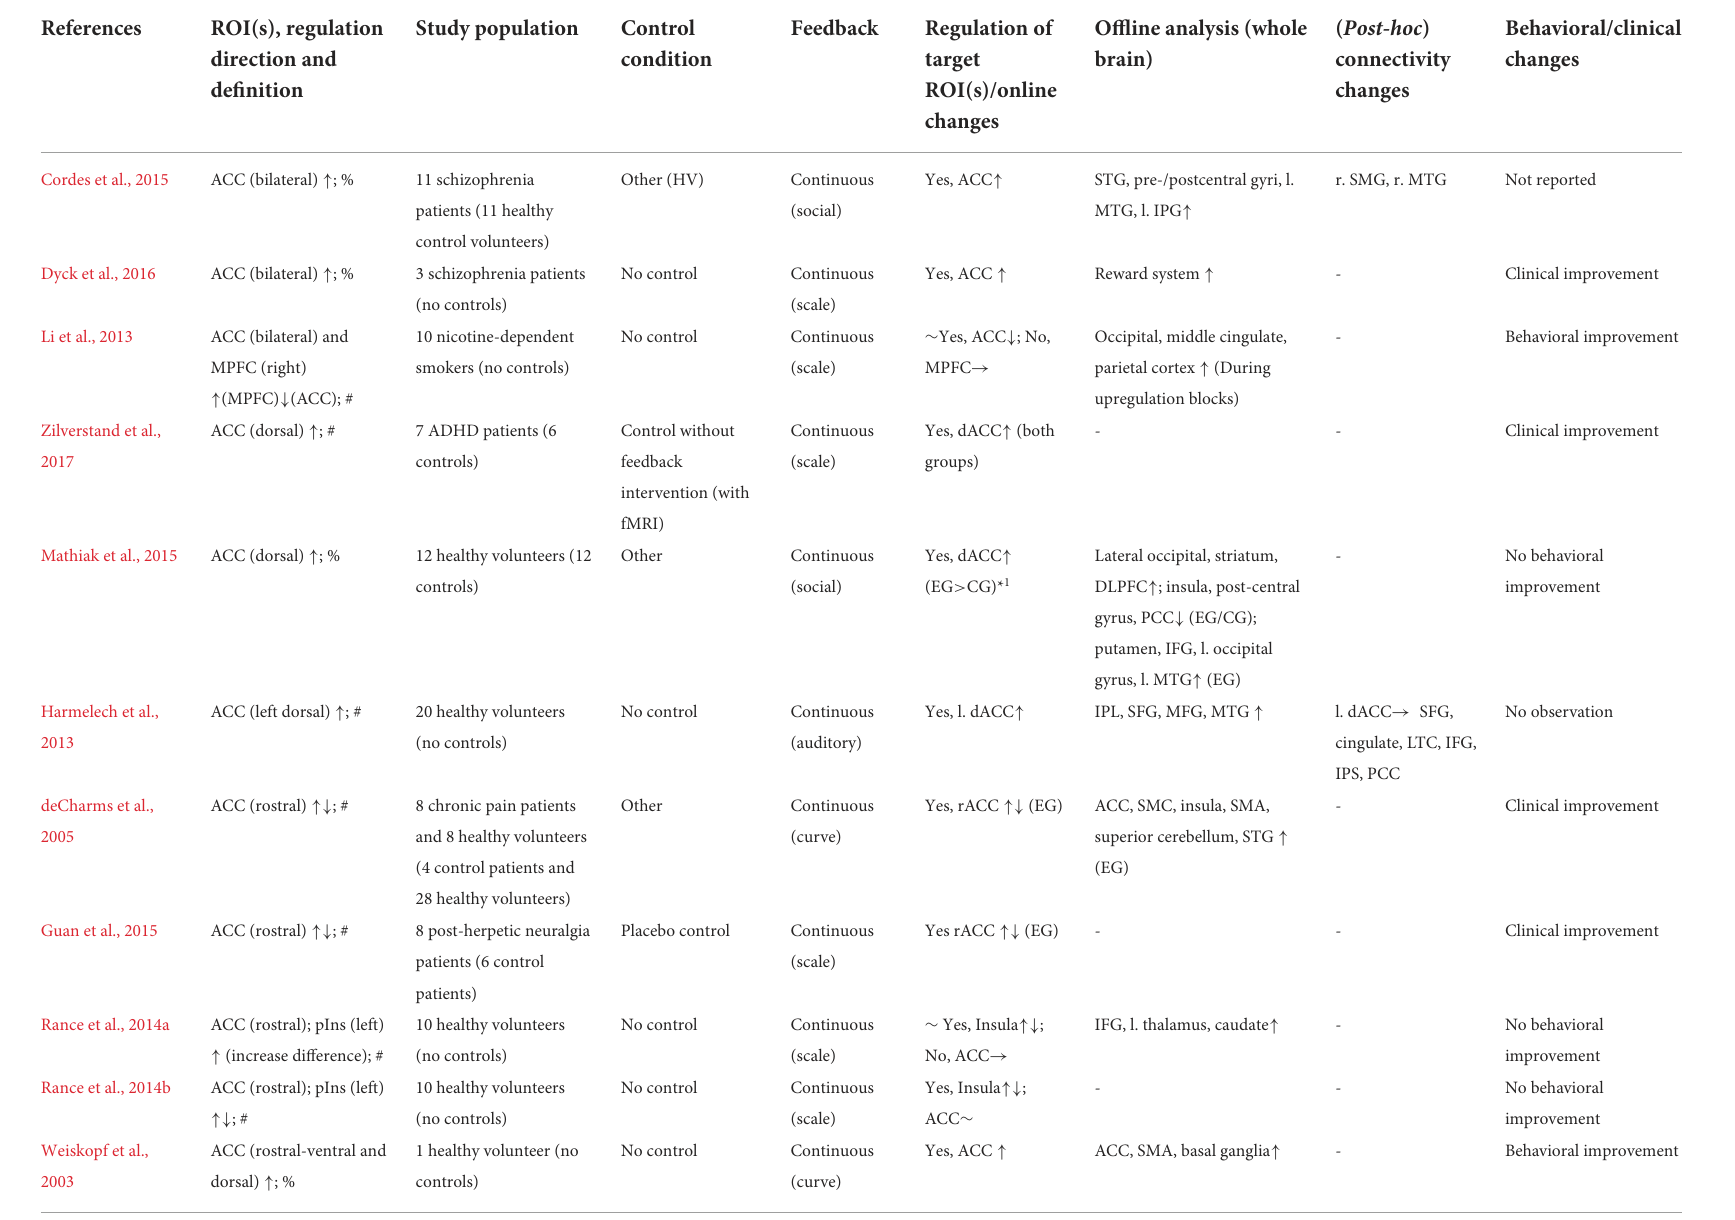
TABLE 1 Details of real-time fMRI neurofeedback studies with regulation target in the “limbic